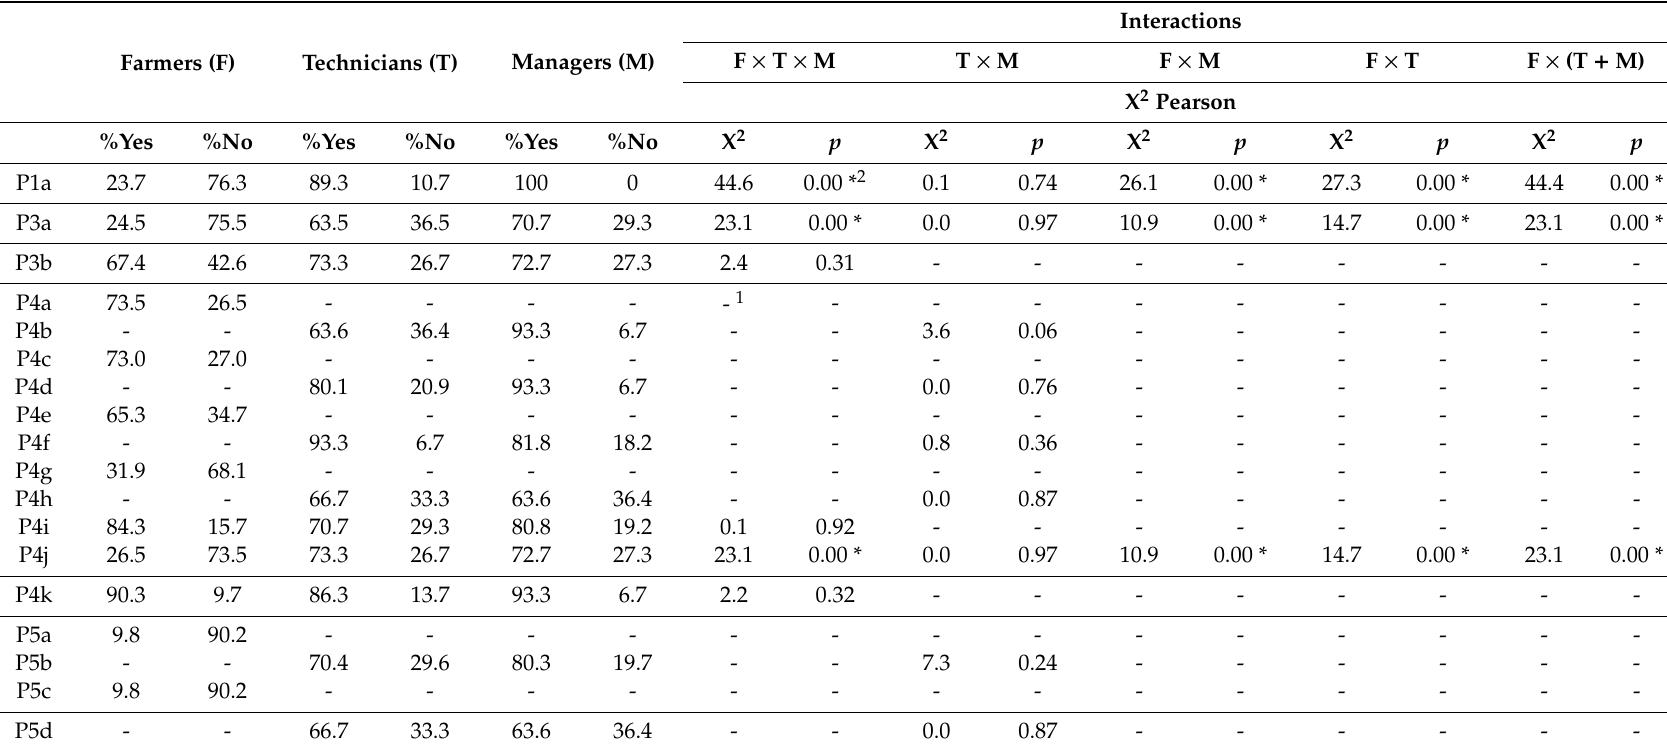
Table 3. Analysis of the dichotomous qualitative variables of the